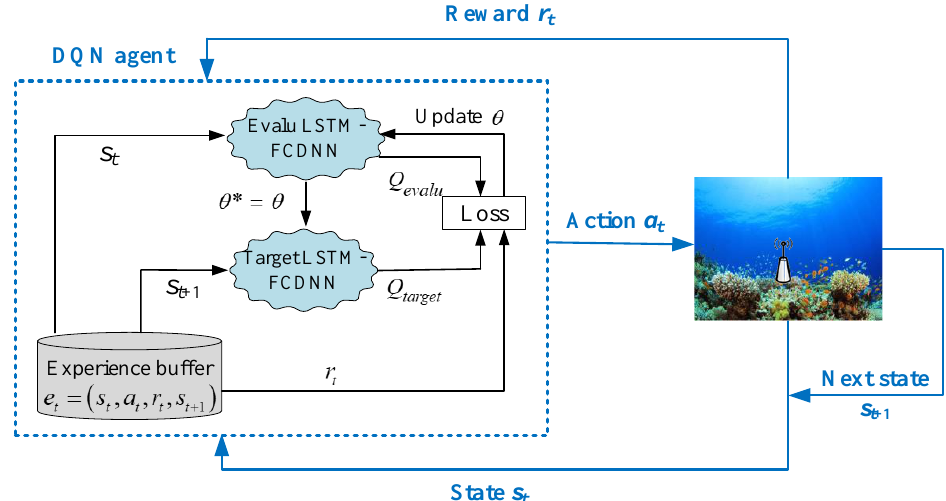
Figure 4. The framework of the LSTM-DQN-based AM